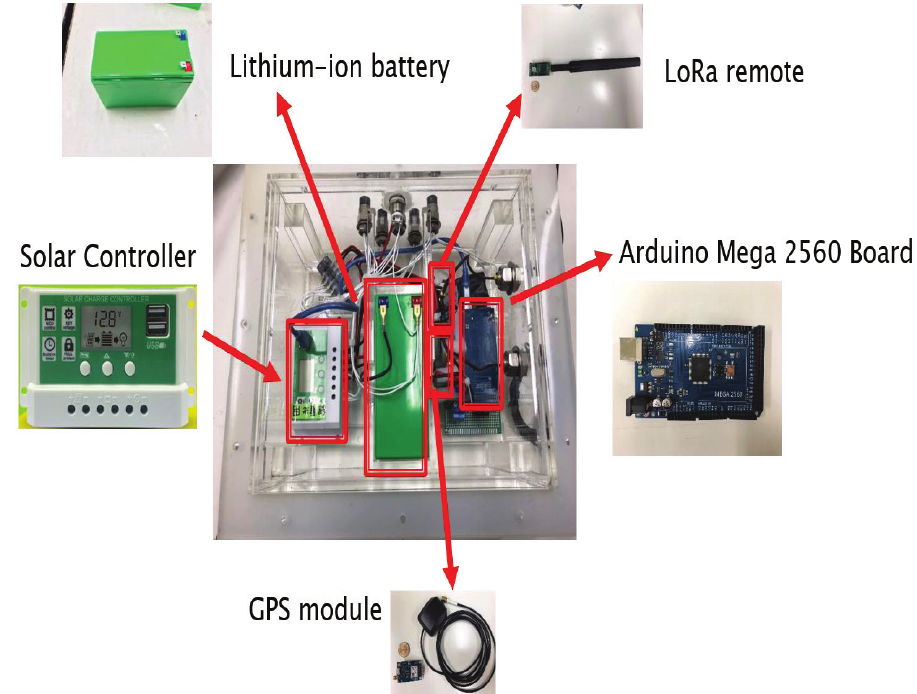
Figure 4. Control box of the proposed AI